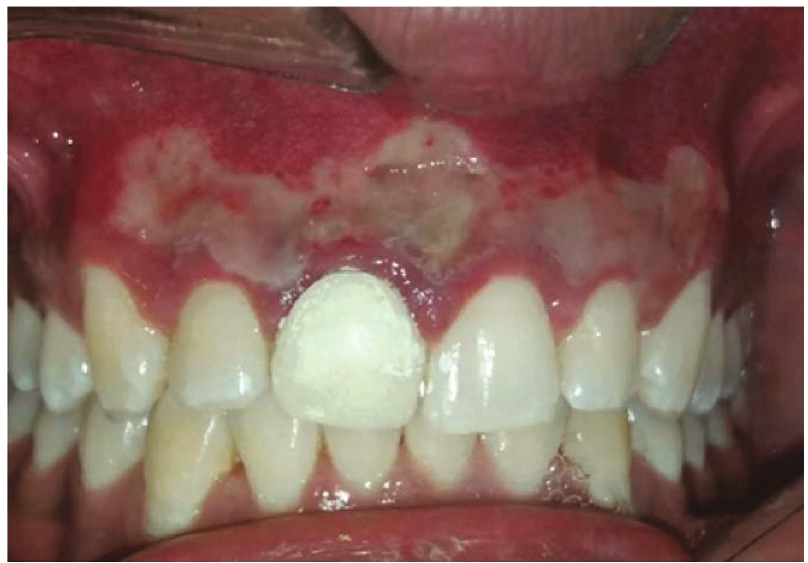
Figure 3: Clinical image showing a fi brin layer that completely covers the “ laser wound ” 6 hours after the operation.